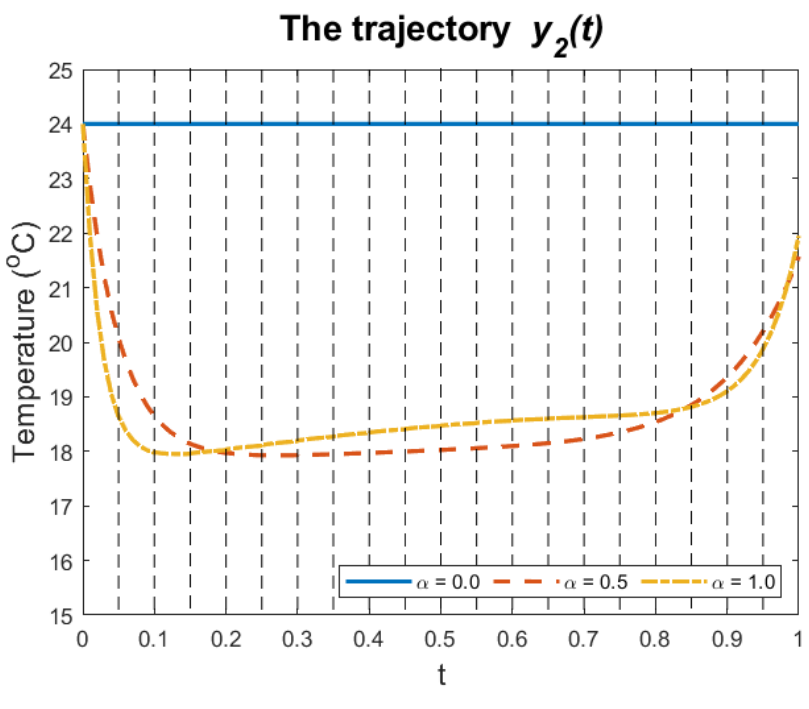
Figure 2. The trajectory of the state variable y 2 ( t ) .